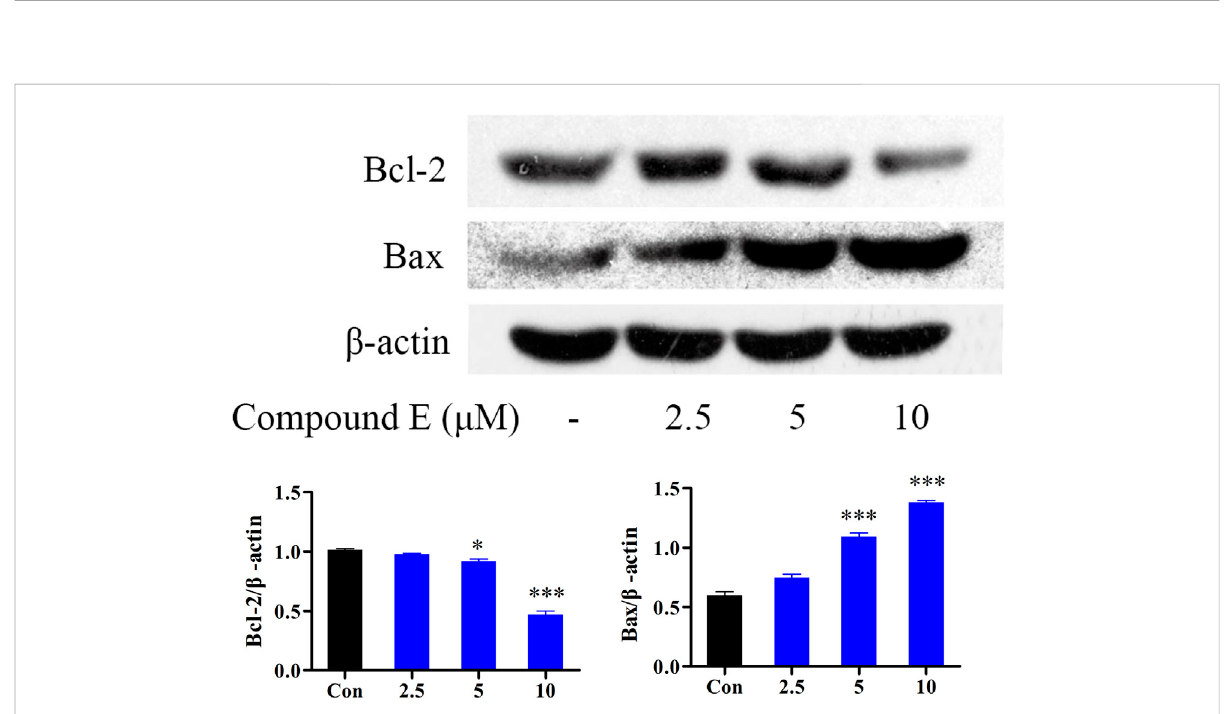
FIGURE 7 Effectofcompound E onthelevelsofBax,andBcl-2inHCT116cells.Cellswerepretreatedwiththevariousconcentrationsofcompound E (2.5, 5and10 μ M)for24 h.TheexpressionofBax,andBcl-2wereanalyzedbyWesternblot.*** p < 0.001,** p < 0.01,* p < 0.05vs.controlgroup.Theerror bars represent the mean ± SD for three independent